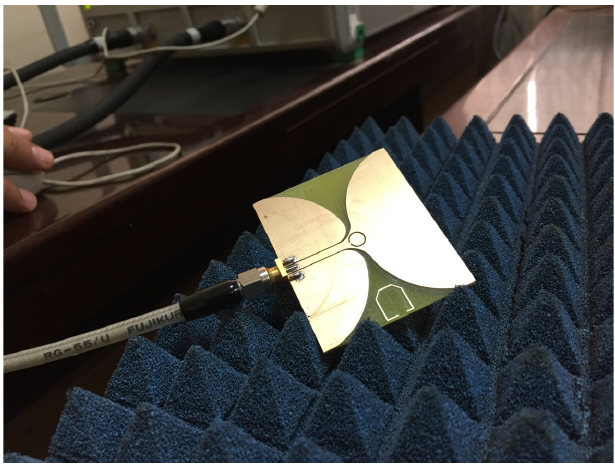
Figure 12: Measurement setup for the dual-band notch antenna.